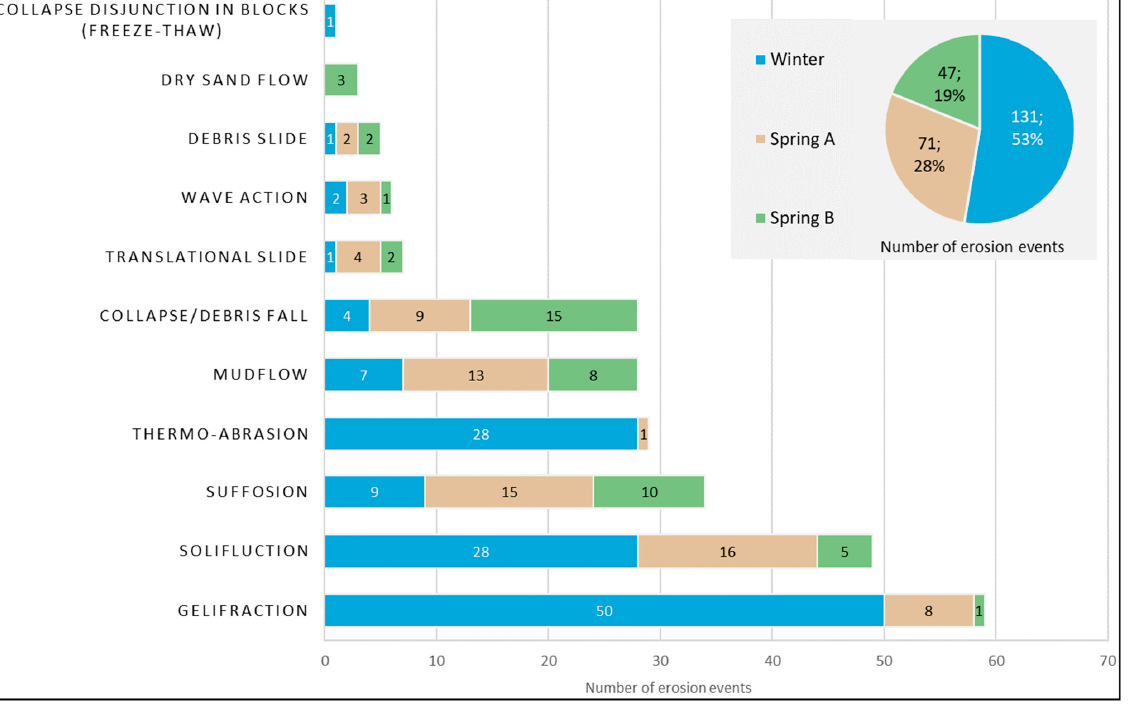
Figure 11. Seasonal distribution of geomorphological erosion processes observed by cameras in winter and spring periods.